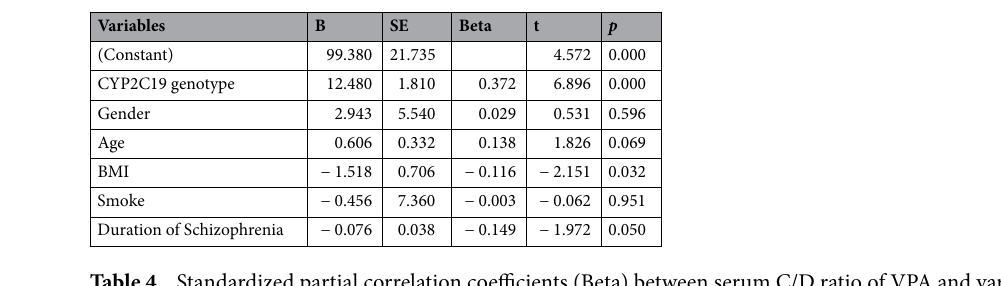
Table 4. Standardized partial correlation coefficients (Beta) between serum C/D ratio of VPA and various factors (n = 298, R 2 = 0.170). EMs: extensive metabolizers; PMs: poor metabolizers.